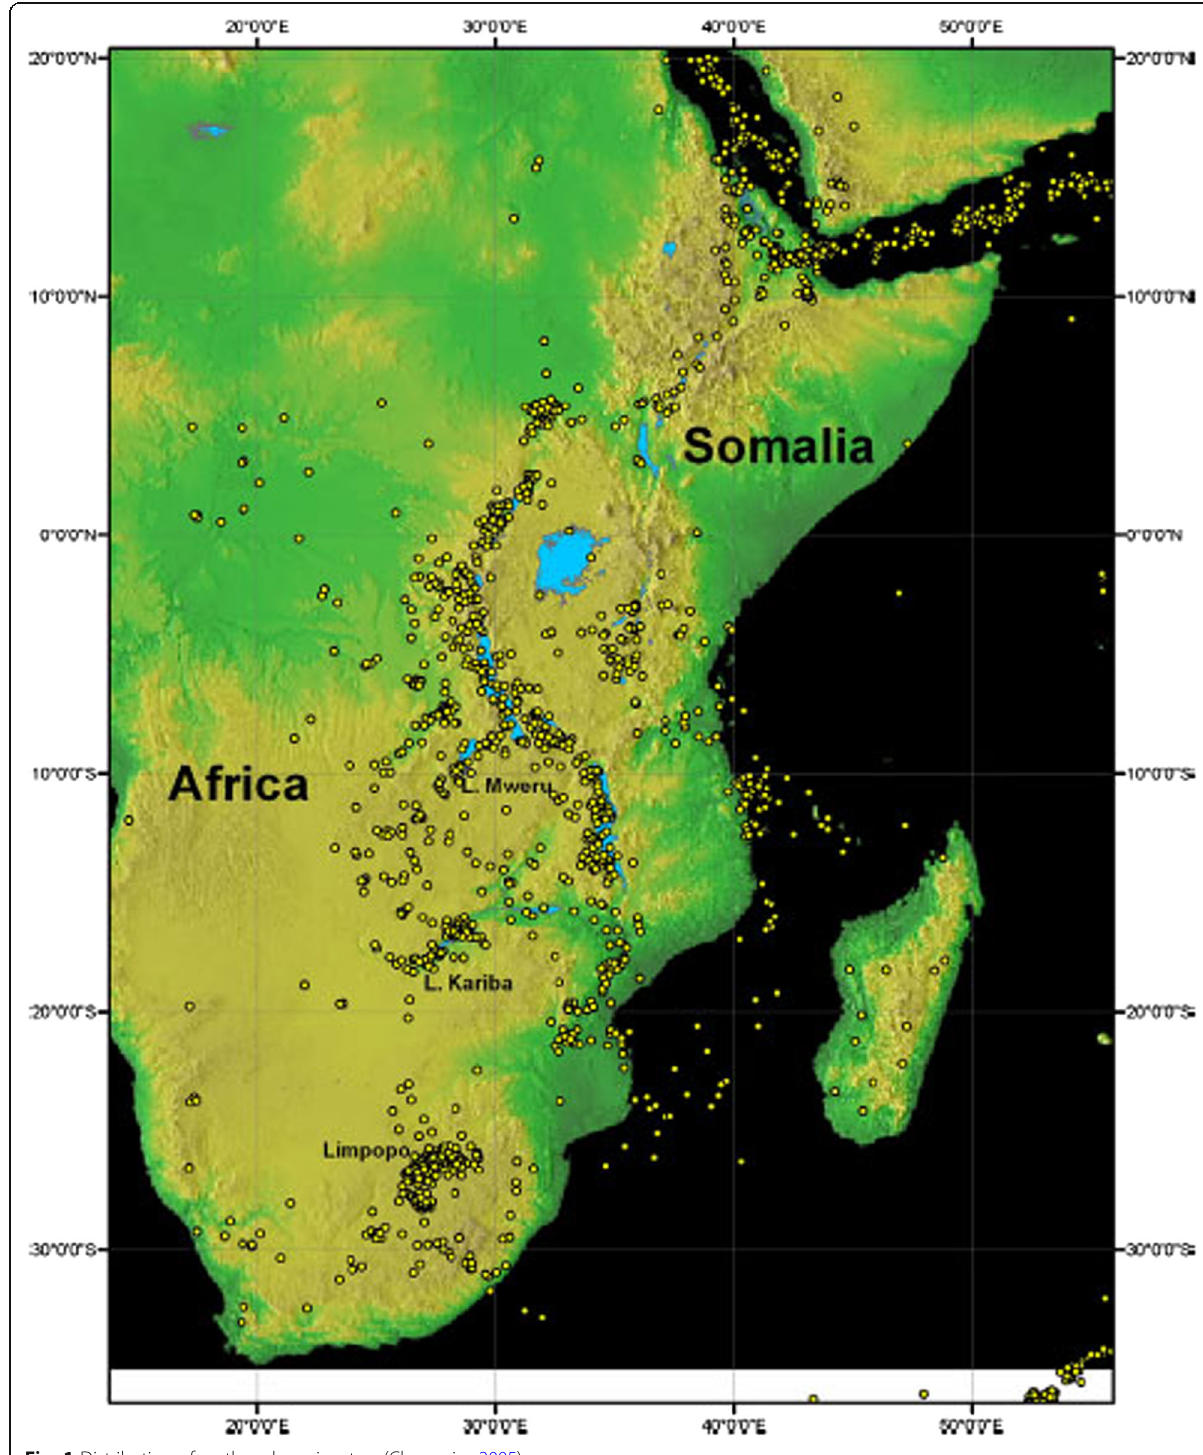
Fig. 1 Distribution of earthquake epicentres (Chorowicz